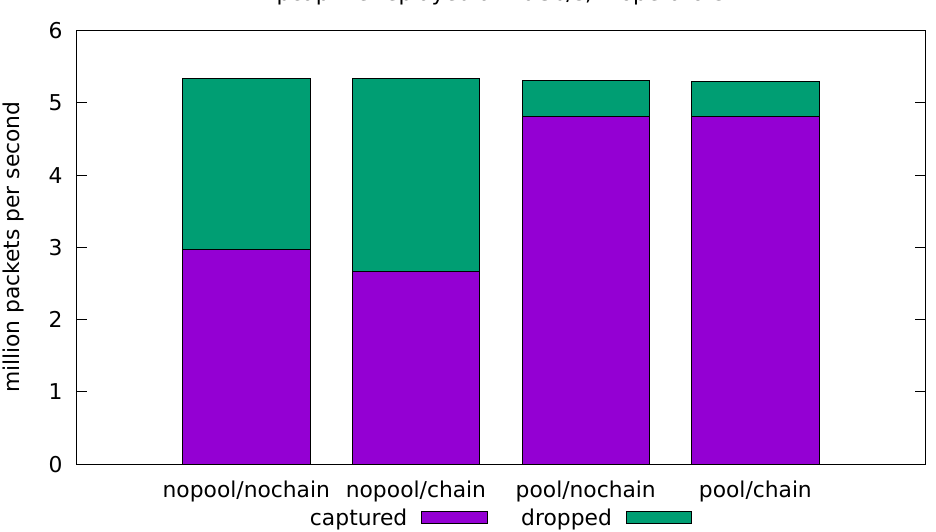
Figure 9. Evaluation on real-traffic replayed at 20 Gb/s from a pcap file. Application is run with all four operators in the processing